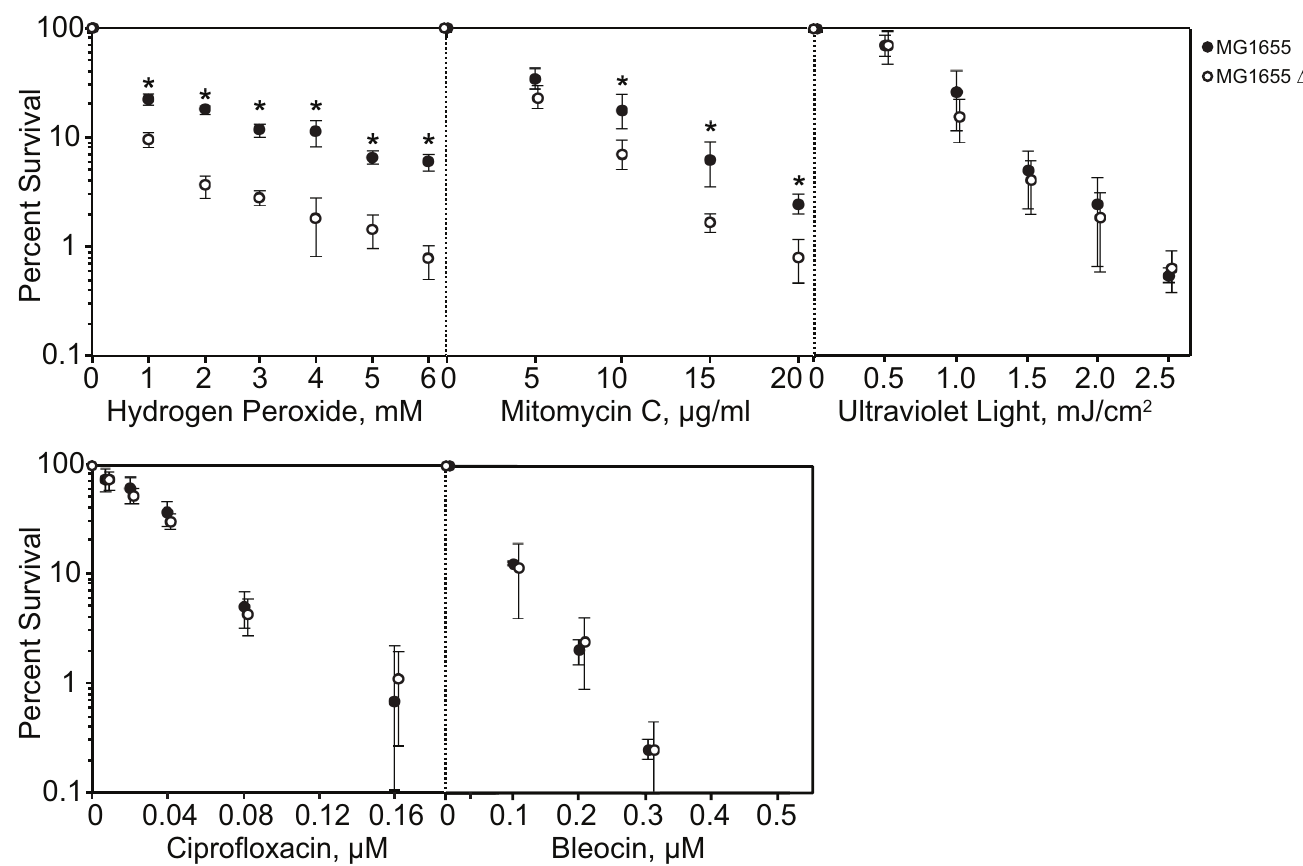
Fig 2. Effect of ligB deletion on bacterial response to DNA damaging agents. Survival of the parent strain MG1655 ( ● ) comparedto the isogenic Δ ligB strain ( (cid:14) ). Percent survival was determinedby dividingthe numberof CFU/ml with the indicatedtreatment by the number of CFU/ml without treatment and these data are shown on a semi-log plot as a function of increasingDNA damagingagent. Error bars denotethe standard deviationcalculatedfrom experiments done in triplicate (repeatedthree times with similar results). Comparingthe parent and the mutant strain for each specific conditionby Student’sT-test, p < 0.05( * ).